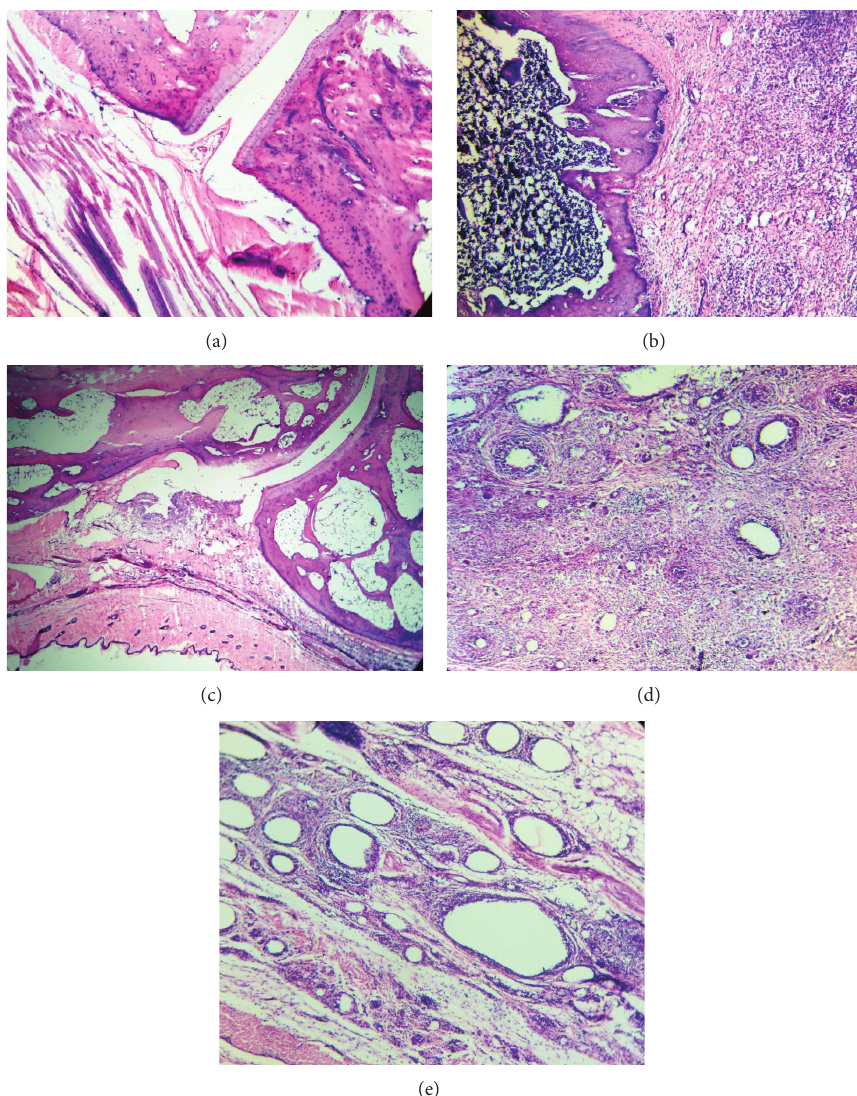
Figure 4: Effect of saponin rich (SR) fraction on histopathological changes of tibiotarsal joints in arthritic rats. All images of one of six in each group. (a) Vehicle control, (b) adjuvant-induced arthritic control, (c) indomethacin (1mg/kg), (d) saponin rich fraction (50mg/kg), and (e) saponin rich fraction